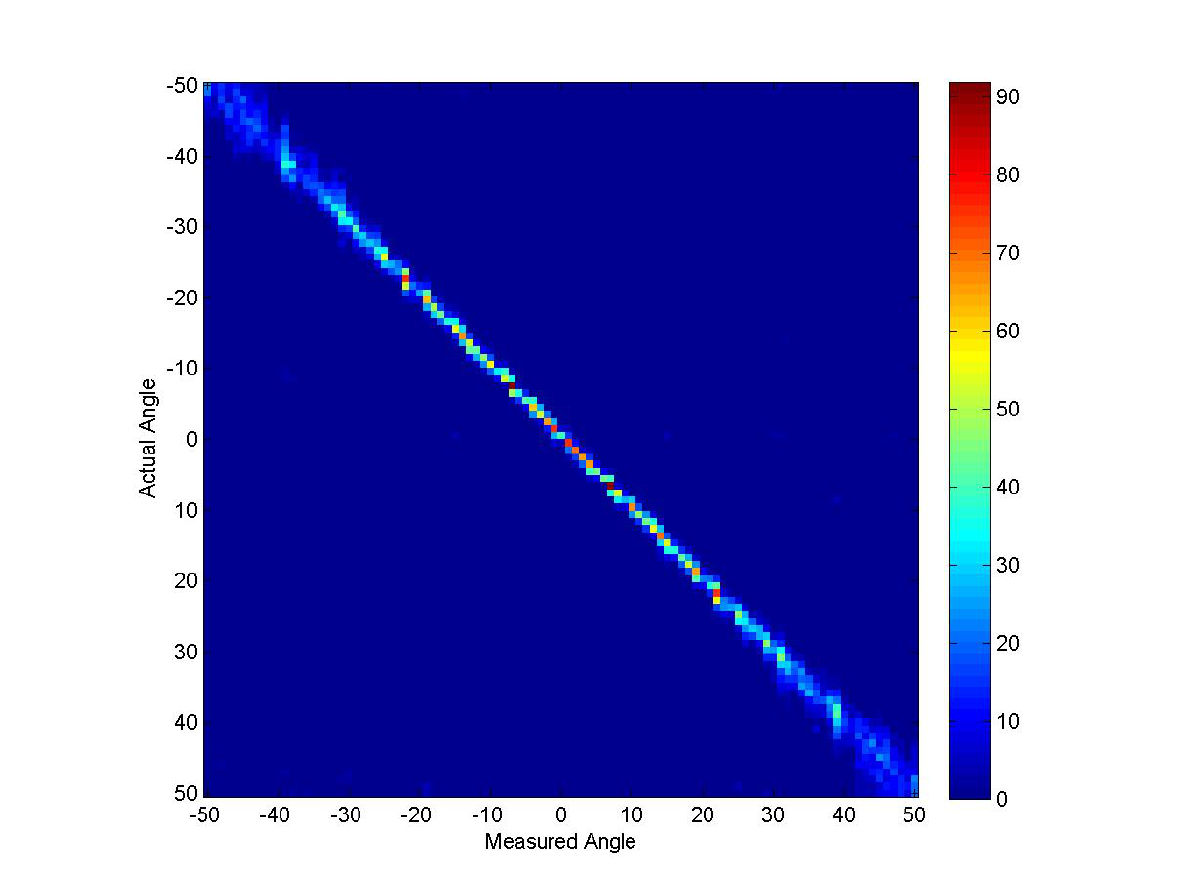
Figure 7. Ambiguity plot for Experiment 1 (13-dB threshold).